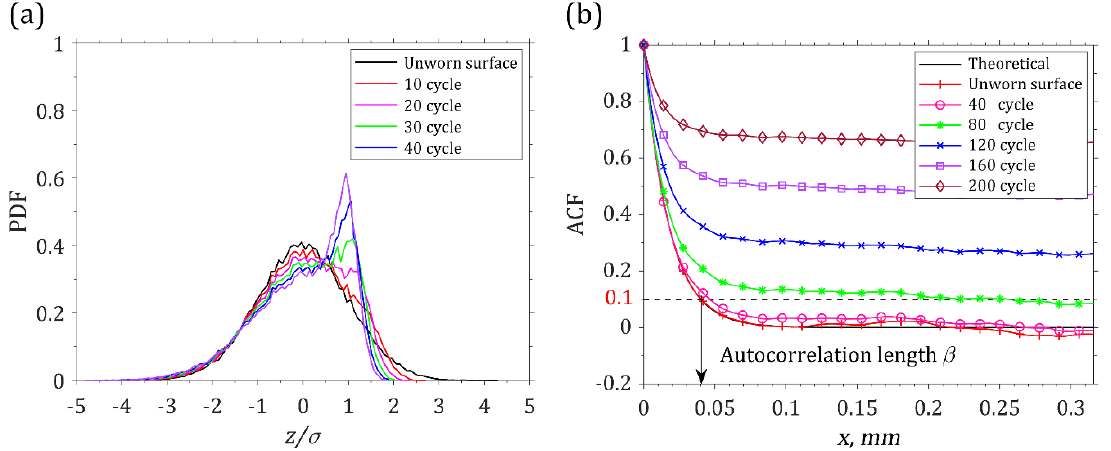
Figure 9. Evolution of functions representing rough surface properties: ( a ) Probability density function; ( b ) autocorrelation function.